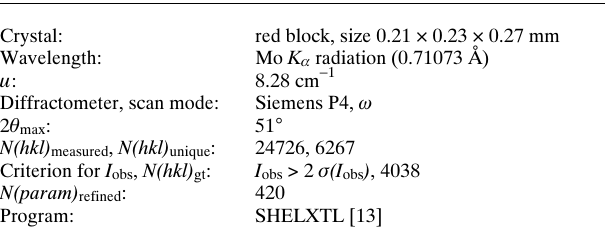
Table 1. Data collection and